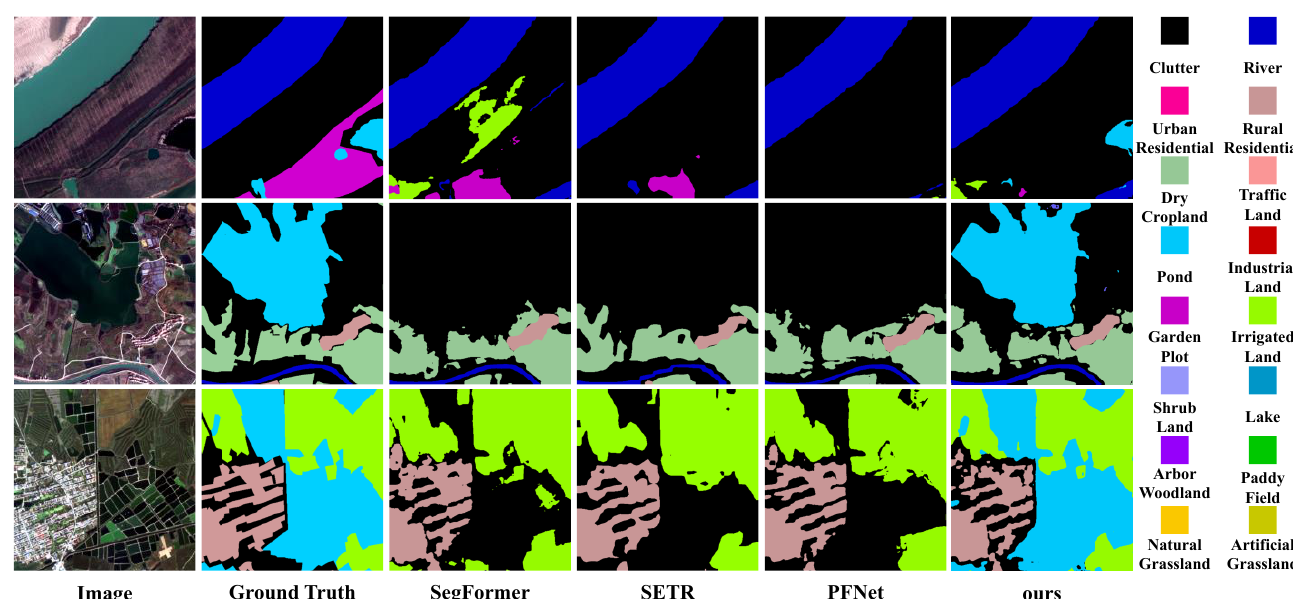
Figure 10. Visualization of results for the GID-15 validation set. Table 8. Quantitative comparison of experiment results on the Potsdam test set with the networks whose backbones are Van-tiny or similar alternatives.